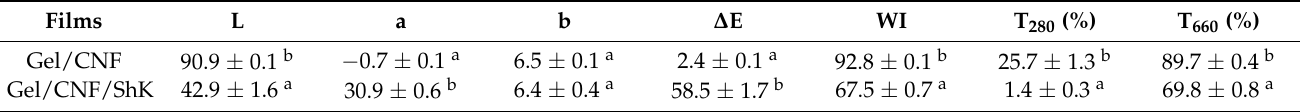
Table 1. Surface color and light transmittance of the smart Gel/CNF films.